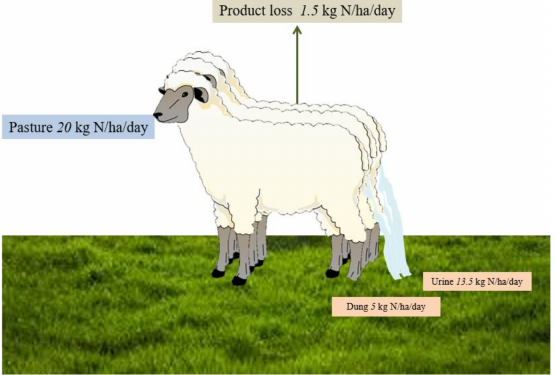
Figure 1. Nitrogen (N) transfer in a sheep grazing system, for one day’s grazing assuming 533 sheep/ha ingesting 800 kg DM pasture @ 2.5% N. Based on Haynes and Williams